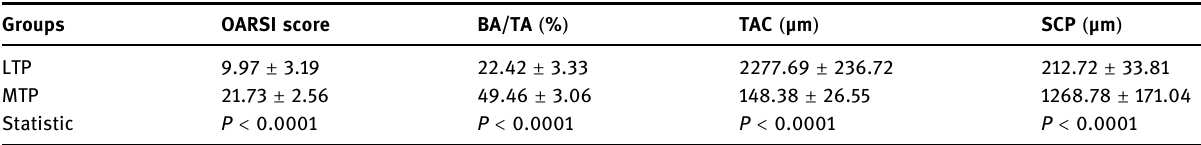
Table 2: Structural parameters of the cartilage and subchondral bone of the medial tibial plateau and the lateral tibial plateau of the knee joint were evaluated by Safranin O/Fast Green staining ( mean ± SD ) Groups